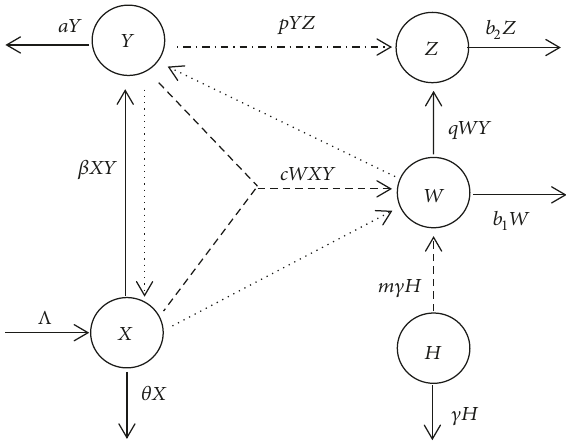
Figure 1: HSCs gene-based therapy transmission